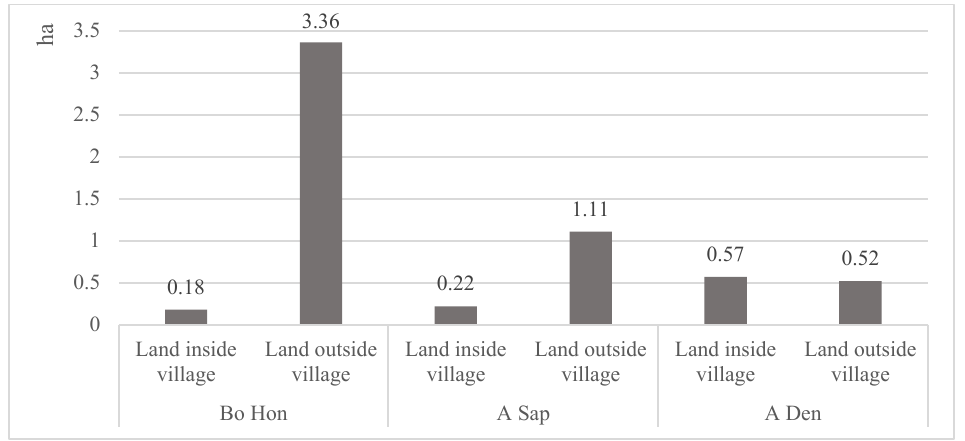
Figure 5. Land owned by households by villages.